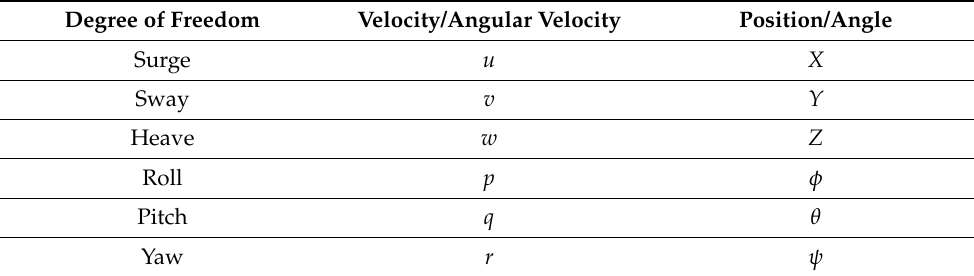
Table 2. Parameters of the six-degree-of-freedom (6-DOF)